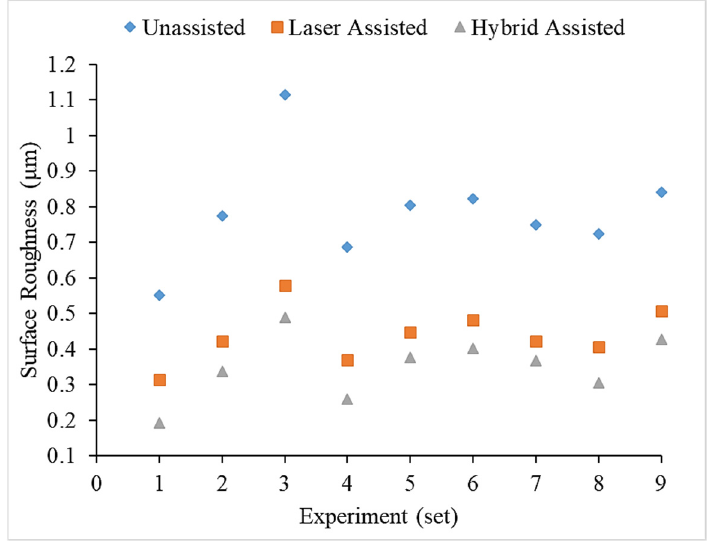
Figure 3. Surface roughness factor response plot for ( a ) unassisted, ( b ) laser-assisted, and ( c ) hybrid- assisted systems.